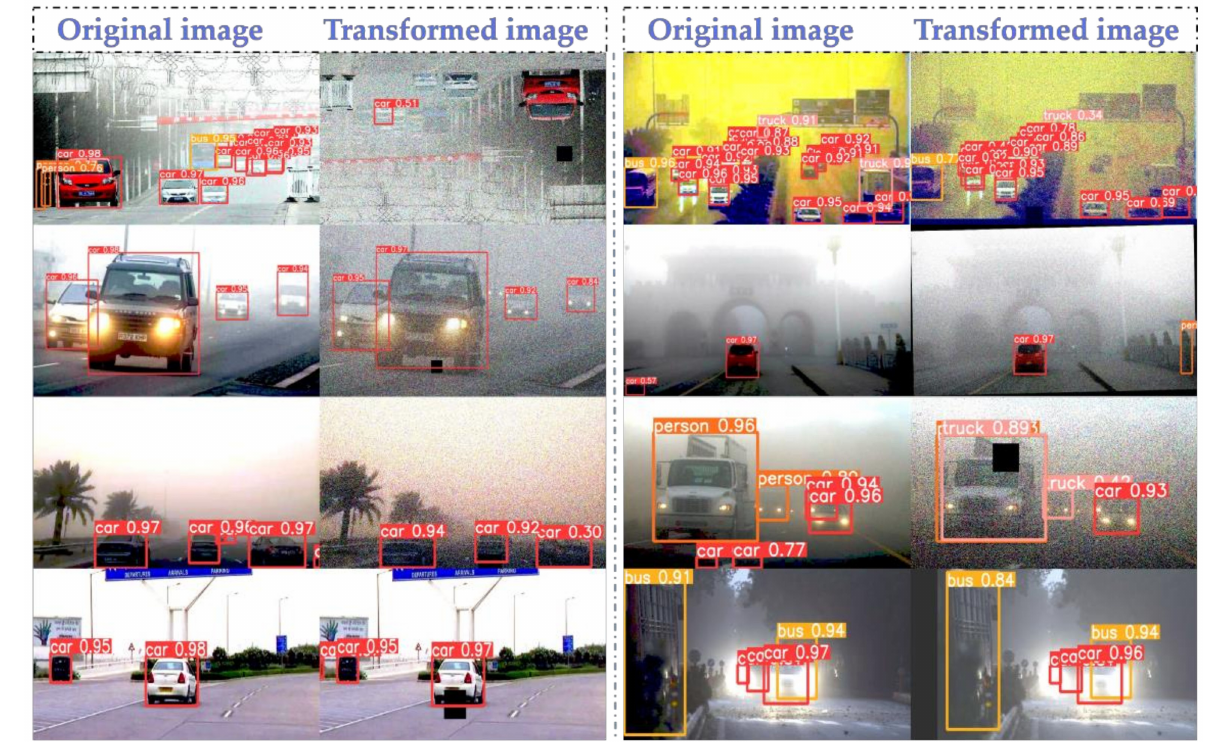
Figure 9. Comparison of test results of failed